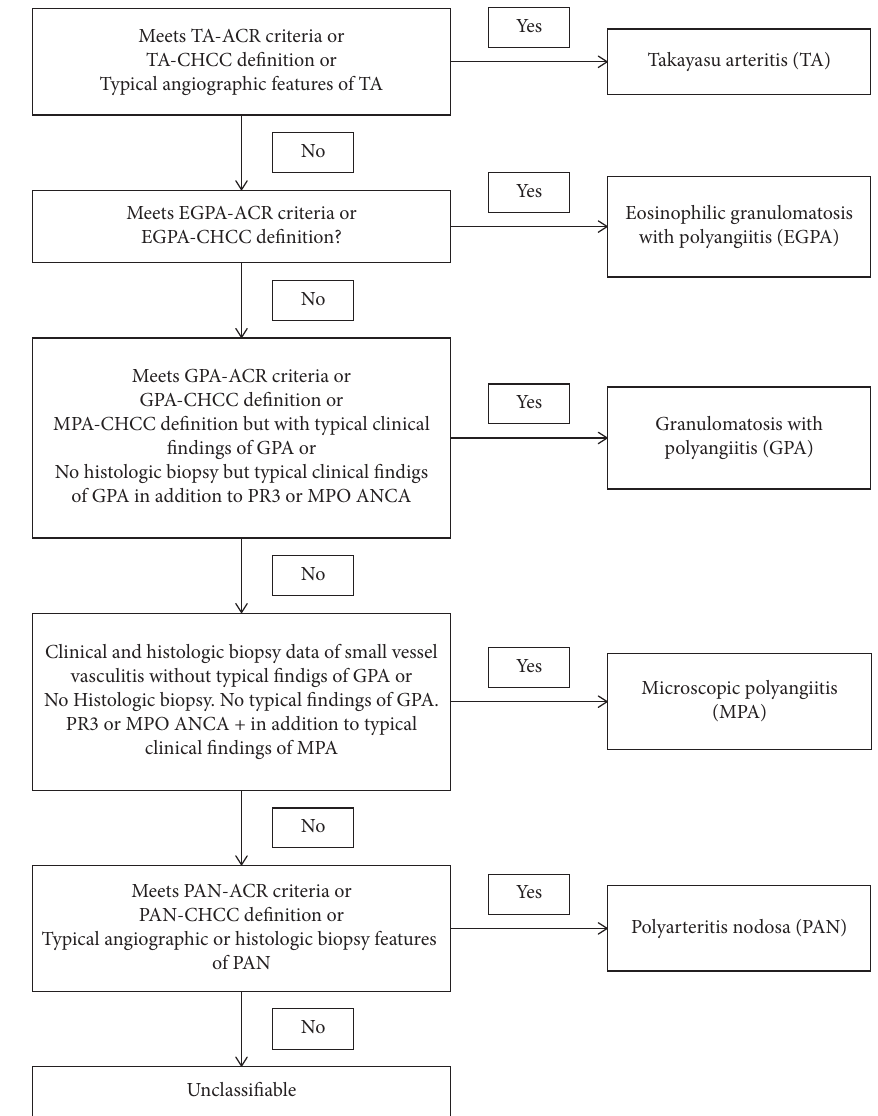
Figure 2: The criteria for the diagnosis of